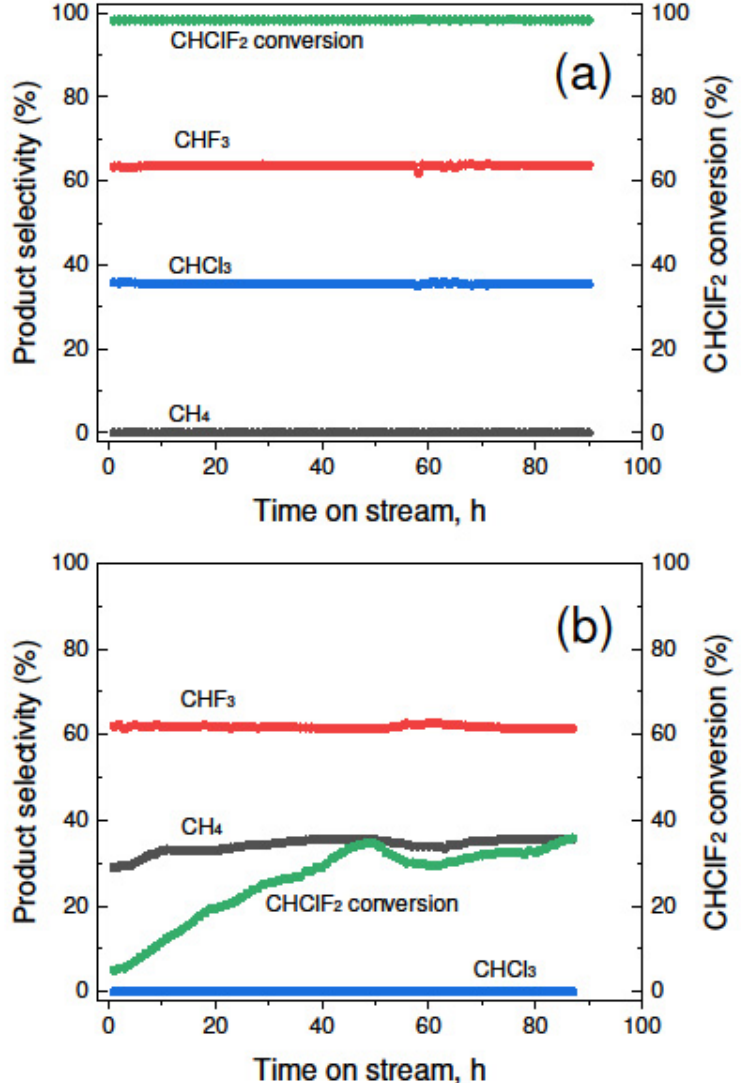
Figure 3. Overall conversions and product selectivities in the hydrodechlorination of freon R-22 over: alumina ( a ) and Pd/Al 2 O 3 ( b ) catalysts. Time-on-stream behavior in long-term experiments. Reaction temperature 180 °C. Operating conditions as in Figure 1.